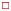
Changes in mechanical properties in the cortical gray matter and caudate-putamen during hydrocephalus development.Mechanical properties of the (a) cortical gray matter in hydrocephalic rats (□) showed a non-significant trend towards increased stiffness at day three and then decreased significantly by day seven, not seen in controls (□). In contrast, (b) the caudate-putamen stiffness in hydrocephalic rats was significantly higher at day three and then non-significant trended towards decreased stiffness. Significant t-tests are reported for each graph.